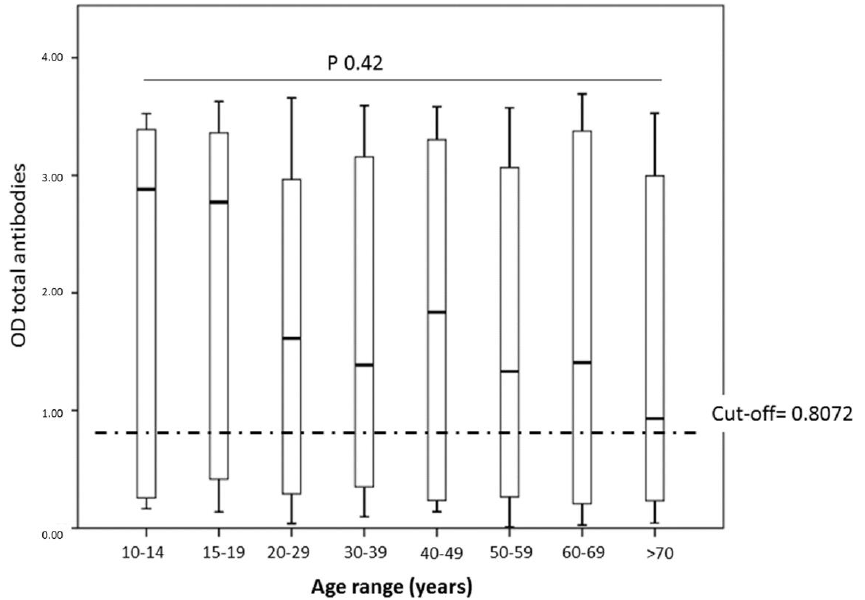
Figure 3. Relationship between the age ranges evaluated against the serological data for SARS-CoV-2. No statistically significant differences were observed when comparing the kinetics of total antibodies against the different age groups. Seropositivity and comorbidities. No statistically significant differences were found with seropositivity between individuals with some comorbidity and those who had none. However, 50% of the individuals with comorbidities had been exposed to this new coro- navirus (Table 3, Figure 4). Table 3. Seropositivity against SARS-CoV-2 with comorbidities and symptoms of COVID-19.